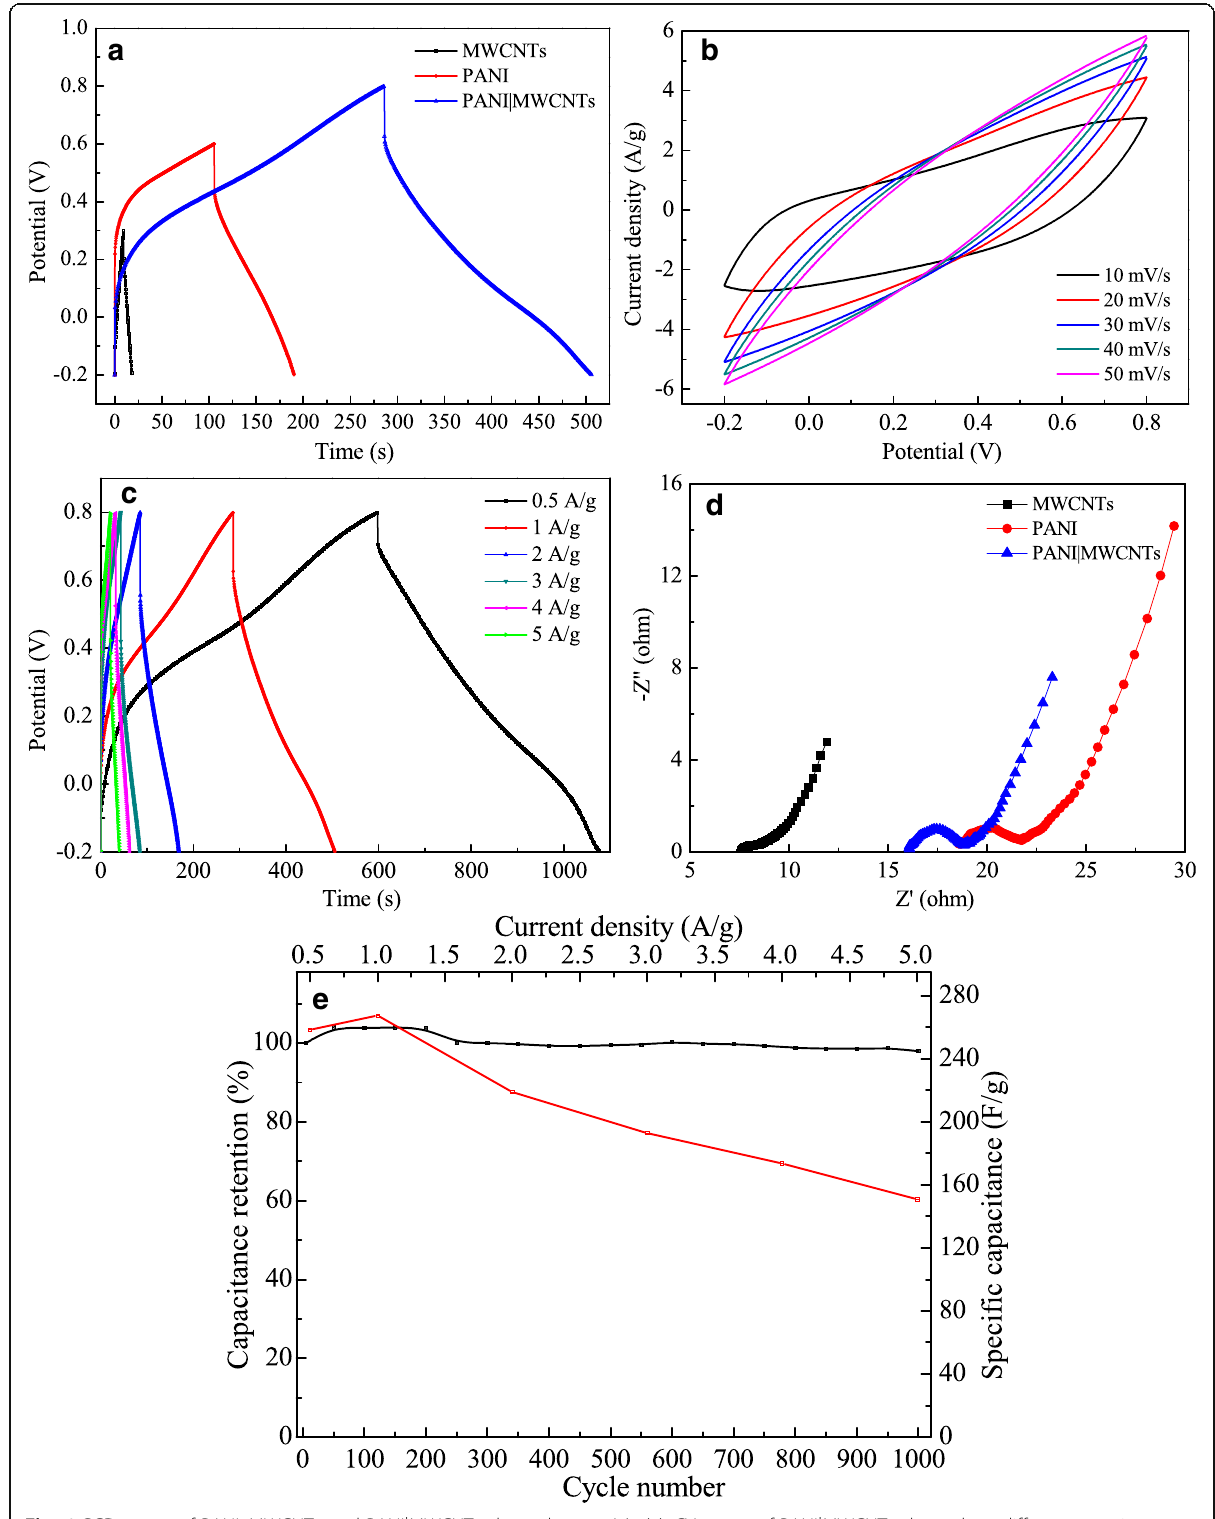
Fig. 6 GCD curves of PANI, MWCNTs, and PANI|MWCNTs electrodes at 1 A/g ( a ); CV curves of PANI|MWCNTs electrode at different scanning speeds ( b ); GCD curves of PANI|MWCNTs electrode at different current densities ( c ); EIS of PANI, MWCNTs, and PANI|MWCNTs electrodes ( d ); the stability after 1000 cycles CVs (black line); and specific capacitance at different current densities (red line) of the PANI|MWCNTs electrode ( e